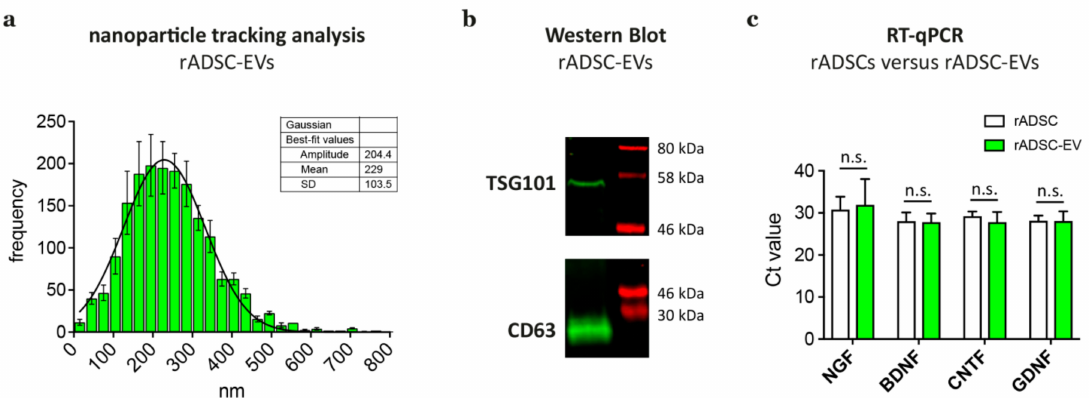
Figure 2. Characterization of rat adipose tissue derived stem cell derived extracellular vesicles (rADSCs-EVs). ( a ) rADSC-EV size distribution results determined by nanoparticle tracking analysis. ( b ) Western blot results of pooled batches of rADSC-EVs stained against TSG101 and CD63; whole blots are depicted in Supplementary Figure S1h. ( c ) RT-qPCR results for RNA expression levels of growth factors NGF , BDNF , CNTF , and GDNF in rADSCs and corresponding rADSC-EVs derived from 5 donors. Data are depicted as mean + SD (n = 5); not significant